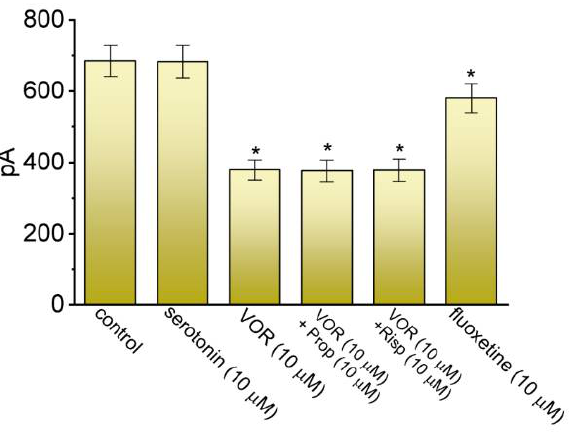
Figure 2. Comparison in inhibitory effects on I K(DR) among serotonin, VOR, VOR plus propranolol (Prop), VOR plus risperidone (Risp) and fluoxetine in GH 3 cells. Current amplitude measured at the end of 1-s depolarizing pulse from − 50 to +50 mV. Each bar indicates the mean ± SEM (n = 7). * Significantly different from control ( p < 0.05). Of note, the serotonin presence has no effect on I K(DR) amplitude, while fluoxetine mildly suppresses it; furthermore, the addition of neither propranolol nor risperidone, still in the presence of VOR, does not reverse VOR-mediated inhibition of I K(DR) . 3.3. Mean Current-Voltage (I-V) Relationship of Peak and Sustained Components of I K(DR)